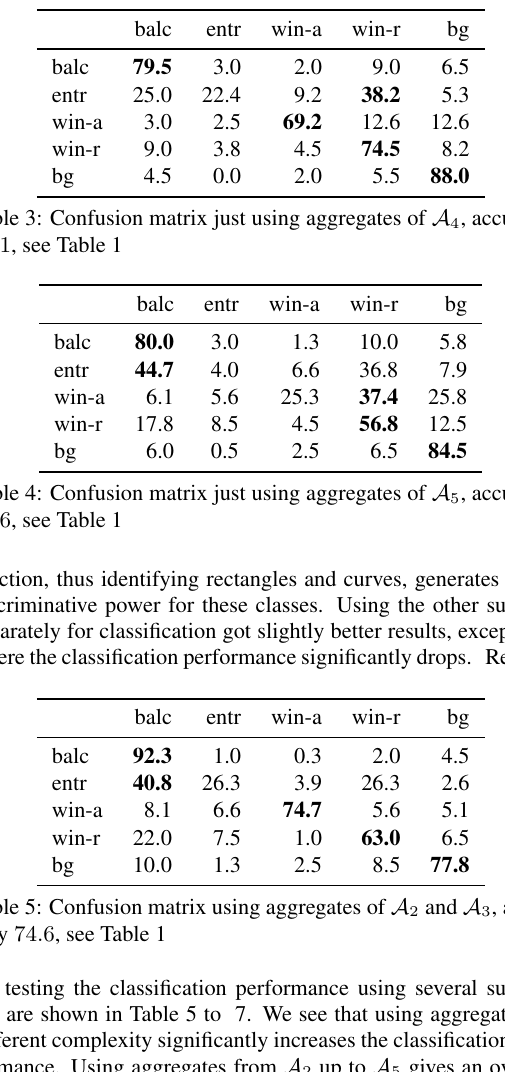
Figure 6: Feature selection, examples for the first 49 selected parts of A 2 to A 4 , extracted from one cross validation step. Please note that these results are similar in all cross validation steps.